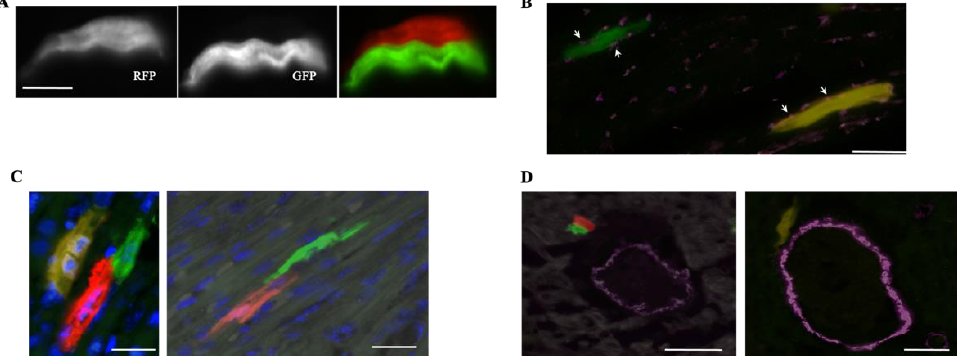
Figure 2. The utility of MADMs in studying cardiogenesis during development: ( a ) MADMs recombination in the Myh6 CreERT2 ;MADM-11 GT/TG model generates two single-labeled RFP + and GFP + cardiomyocytes. (Scale bar, 15 μ m) [25]; ( b ) staining for connexin43 (white arrows) reveals a GFP + cell integrating into the myocardium (scale bar, 5 μ m) [25]; ( c ) single-labeled RFP + and GFP + cardiomyocytes (generated by the β -actin CreER ; MADM-11 GT/TG model) exhibiting intimate end-on contact (scale bars, 10 μ m) [25]; ( d ) in the β -actin CreER ;MADM-11 GT/TG model, cardiomyocytes and smooth muscle cells exhibit different MADM labeling (scale bars, 20 μ m) [25].